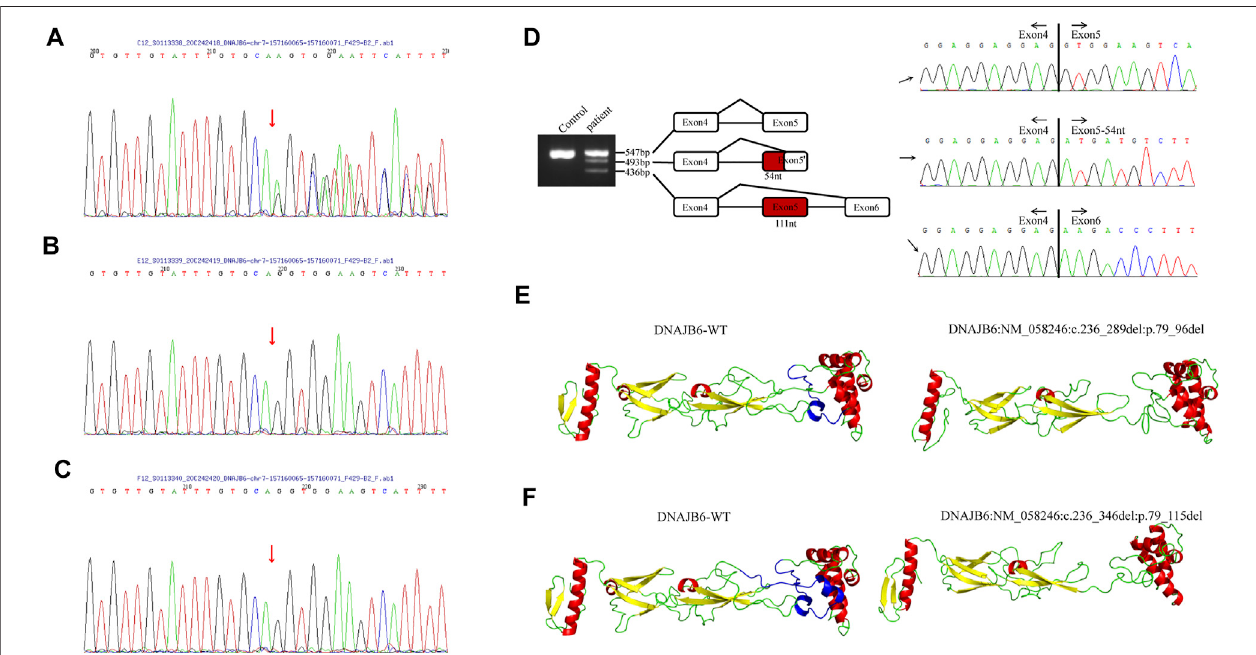
FIGURE 3 | (A – C) The results of Sanger sequencing of the patient and her parents. (A) A heterozygous mutation c.236-1_240delGGTGGA (p.G79Efs*4) of the DNAJB6 gene was identi fi ed, and the mutational site of the patient was con fi rmed by Sanger sequencing. Sanger veri fi cation of her father (B) and mother (C) showed that this site was normal. (D) . DNAJB6 transcript sequencing: Gel electrophoresis of the patient showed three different size bands, namely, 547, 493, and 436 bp. The 547 bpbandisofthesamesizeasthecontroloneandisawild-typetranscript.Bysequencing,the493 bpbandrefersto54-nucleotidedeletionatthebeginningof exon 5, and the 436 bp band refers to the whole 111-nucleotide delete of exon5, which encodes the G/F domain. (E,F) I-TASSER software was used to develop a suitable model to simulate the effect of the mutation region; the 3D protein modeling predicted that p.79_96del mutation would result in the loss of an α -helix (E) and p.79_115del mutation would result in the loss of two α -helices (F) .